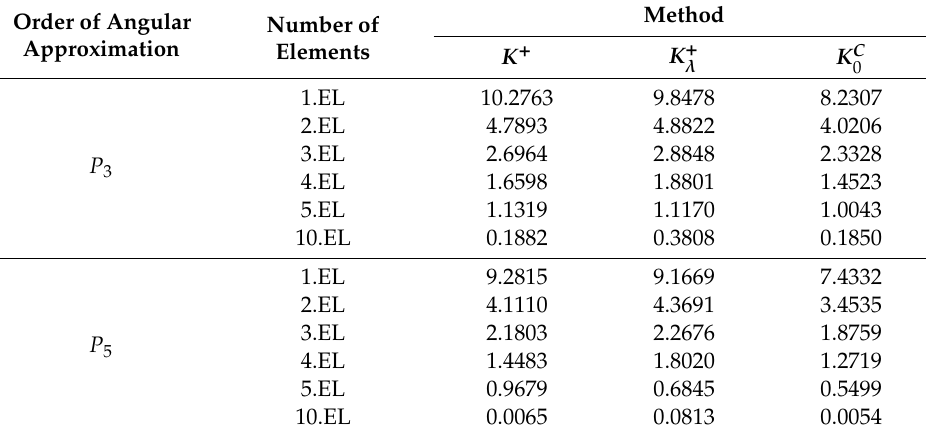
Table 5. Relative errors for P 3 , P 5 approximations with a set of elements for region 4. Order of Angular Number of Approximation